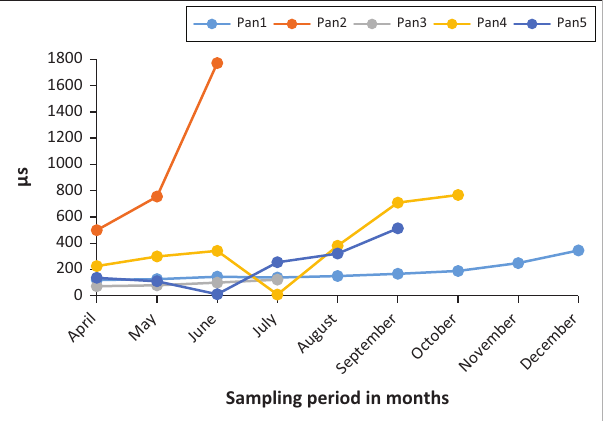
FIGURE 6: The conductivity readings in μS of five pans in Gras-Holpan between April and December 2019, where Pans 2 and 3 were in the savanna biome and Pans 1, 4 and 5 in the Nama-Karoo biome.